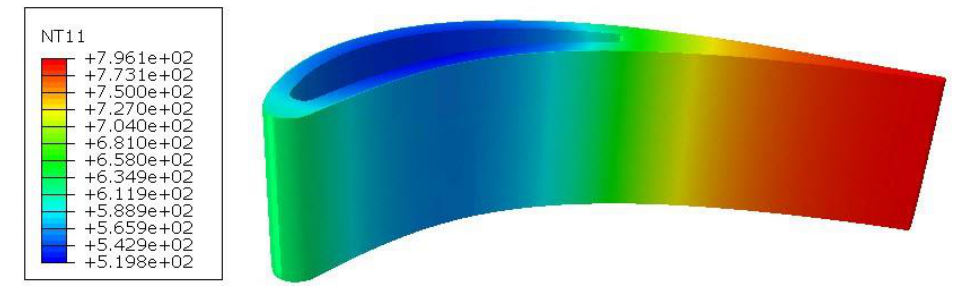
Figure 7. Temperature distribution in the blade.